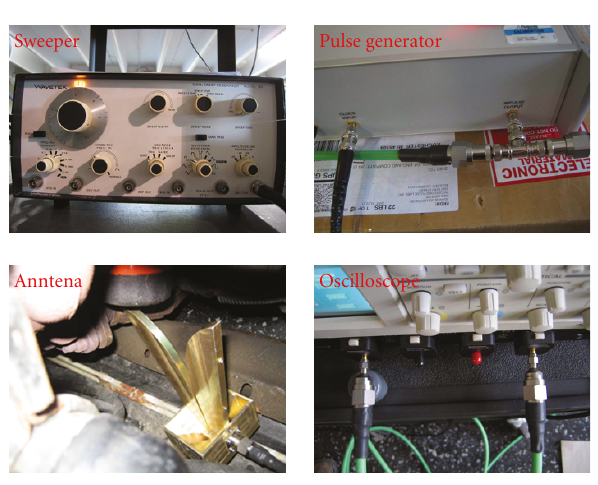
Figure 2: Channel sounding apparatus.